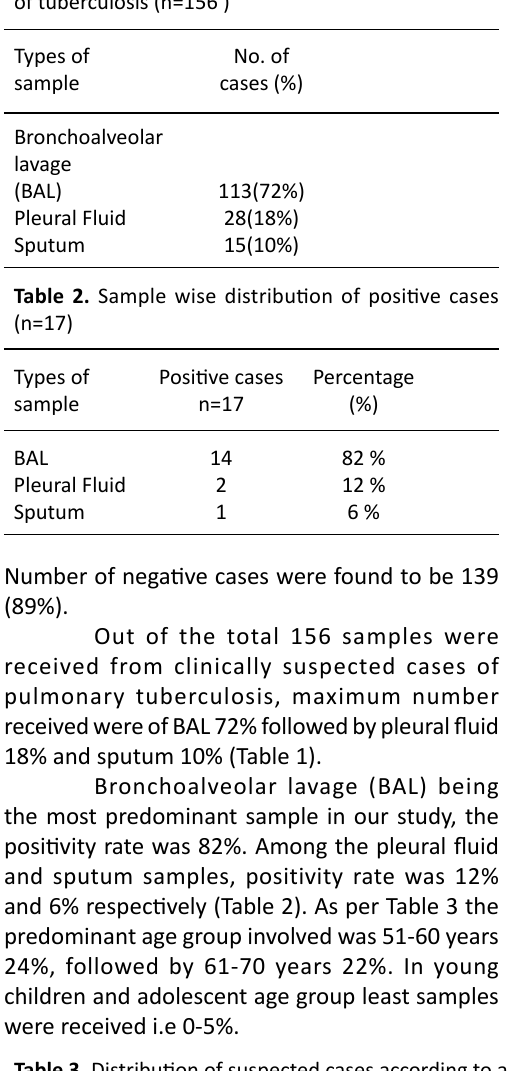
Table 3. Distribution of suspected cases according to age group (n=156)